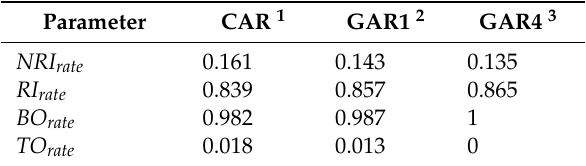
Table 7. Input and output results for CAR, GAR1 and